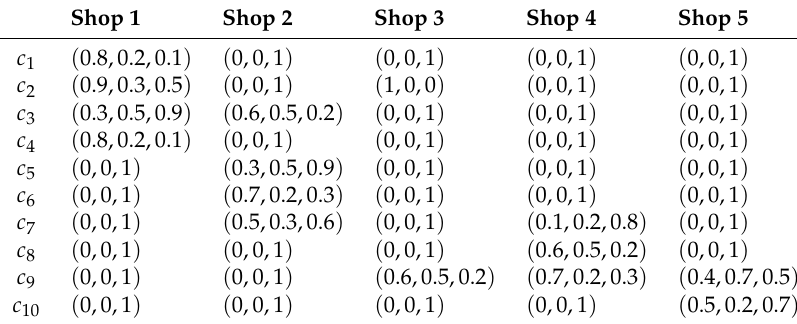
Figure 9. The bottom-up construction procedure. Table 2. Incidence matrix of the express